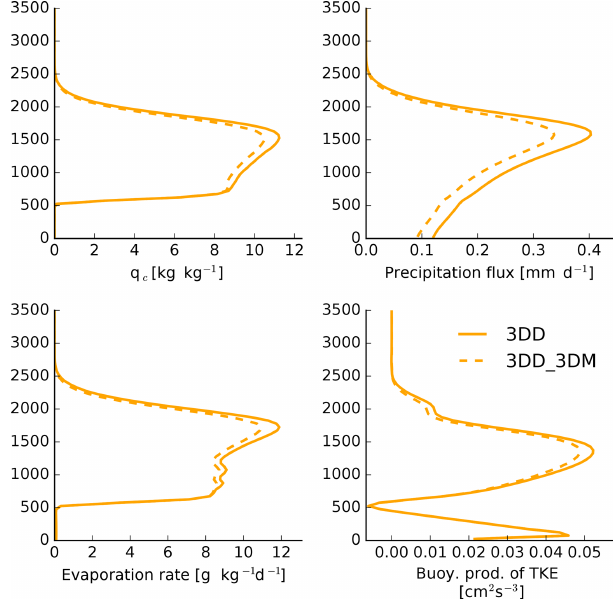
Figure 17. Time-averaged profiles of cloud water mixing ratio, pre- cipitation flux, evaporation rate and buoyancy production of the TKE averaged from 6.7 to